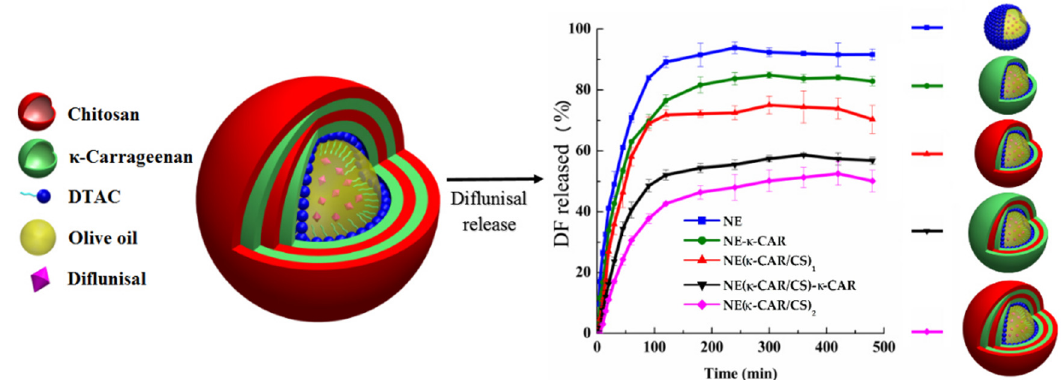
Figure 5. Diflunisal cumulative release profiles at pH 7.4 and 37 ◦ C from polyelectrolyte-free nanoemulsion (NE) and nanocapsules with one (NE-k-CAR), two (NE(k-CAR/CS) 1 ), three (NE(k-CAR/CS) 1 -k-CAR), and four (NE(k-CAR/CS) 2 ) polyelectrolyte layers. DTAC—dodecyltrimethylammonium chloride; DF—diflunisal; CS—chitosan; k-CAR—k-carrageenan. Reproduced from [26], with permission from MDPI, 2021.